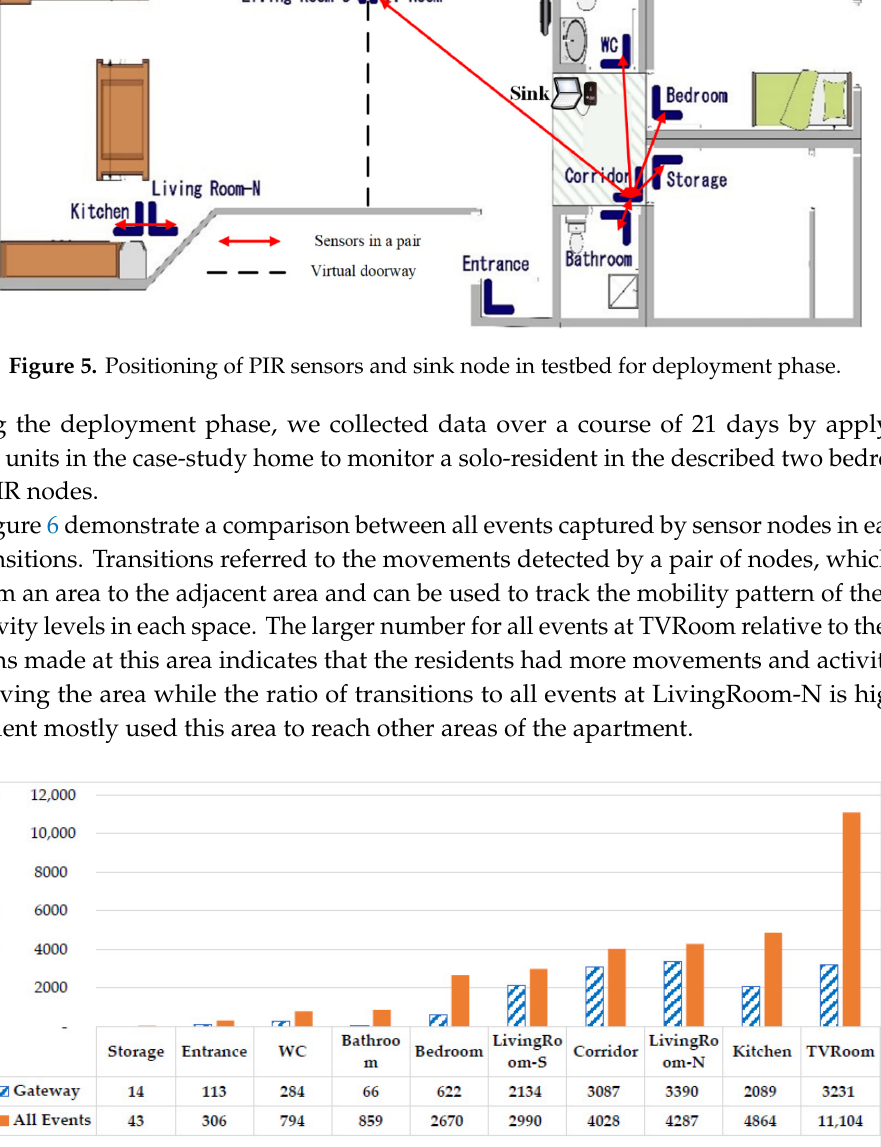
Figure 6. Comparison between all collected events and transitions in deployment phase.